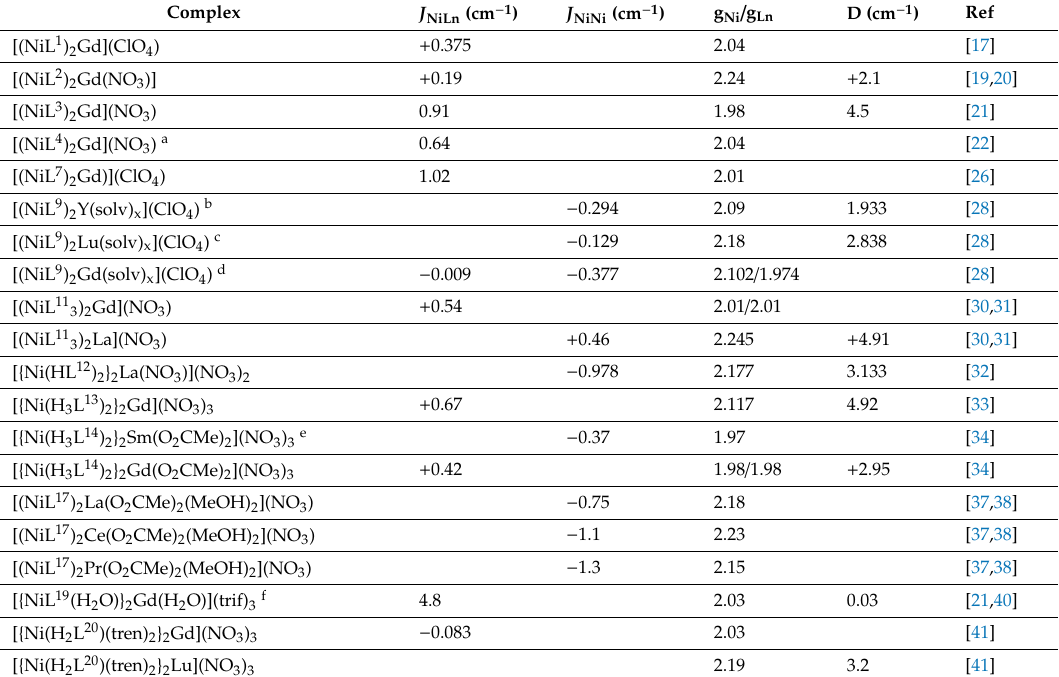
Table 2. Magnetic exchange parameters of the trinuclear Ni 2 Ln